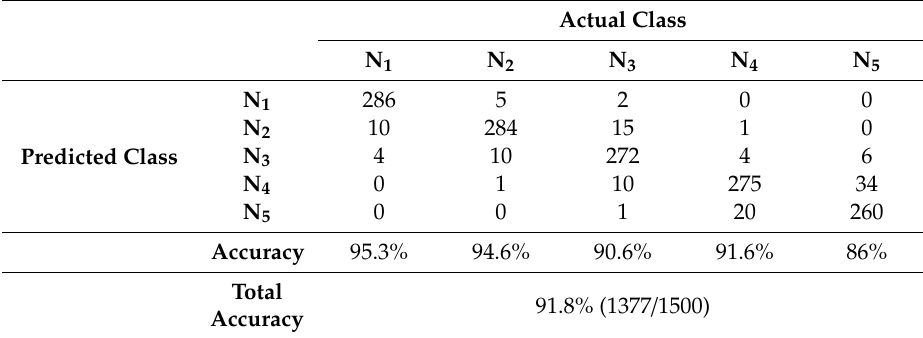
Figure 18. Division of the infrared image for the insertion of the artificial anomaly. Table 2. The confusion matrix of the trained Kohonen self-organizing feature map (SOFM). Actual